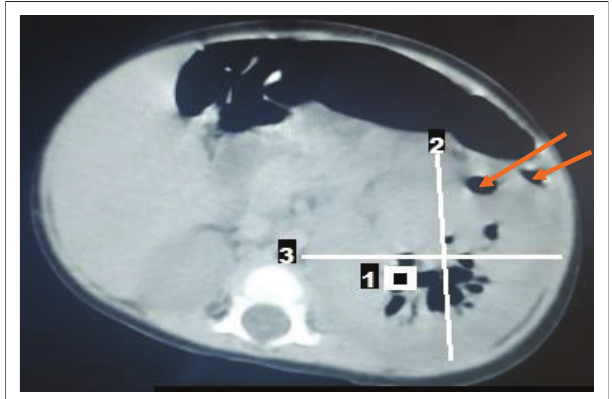
FIGURE 3: Non–contrast-enhanced computed tomogram of an emphysematous pyelonephritis patient at the Usmanu Danfodiyo University Teaching Hospital, Sokoto, Nigeria, November 2019. Figure shows left renomegaly with multiple air density area within the parenchyma and subcapsular region (orange